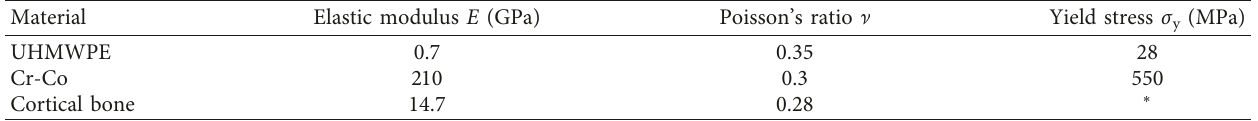
Table 3: Elastic mechanical properties of the materials involved in the FEA [16].